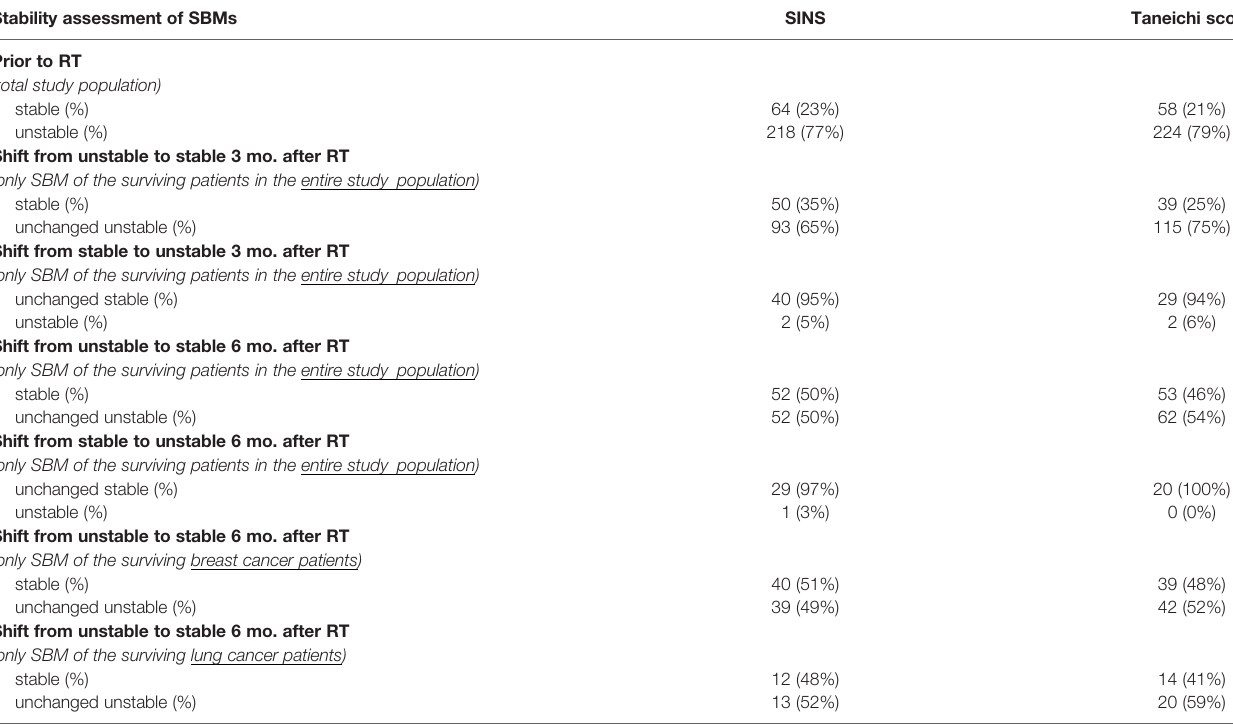
TABLE 2 | Radiogenic changes in vertebral body stability according to SINS and Taneichi Score. Stability assessment of SBMs